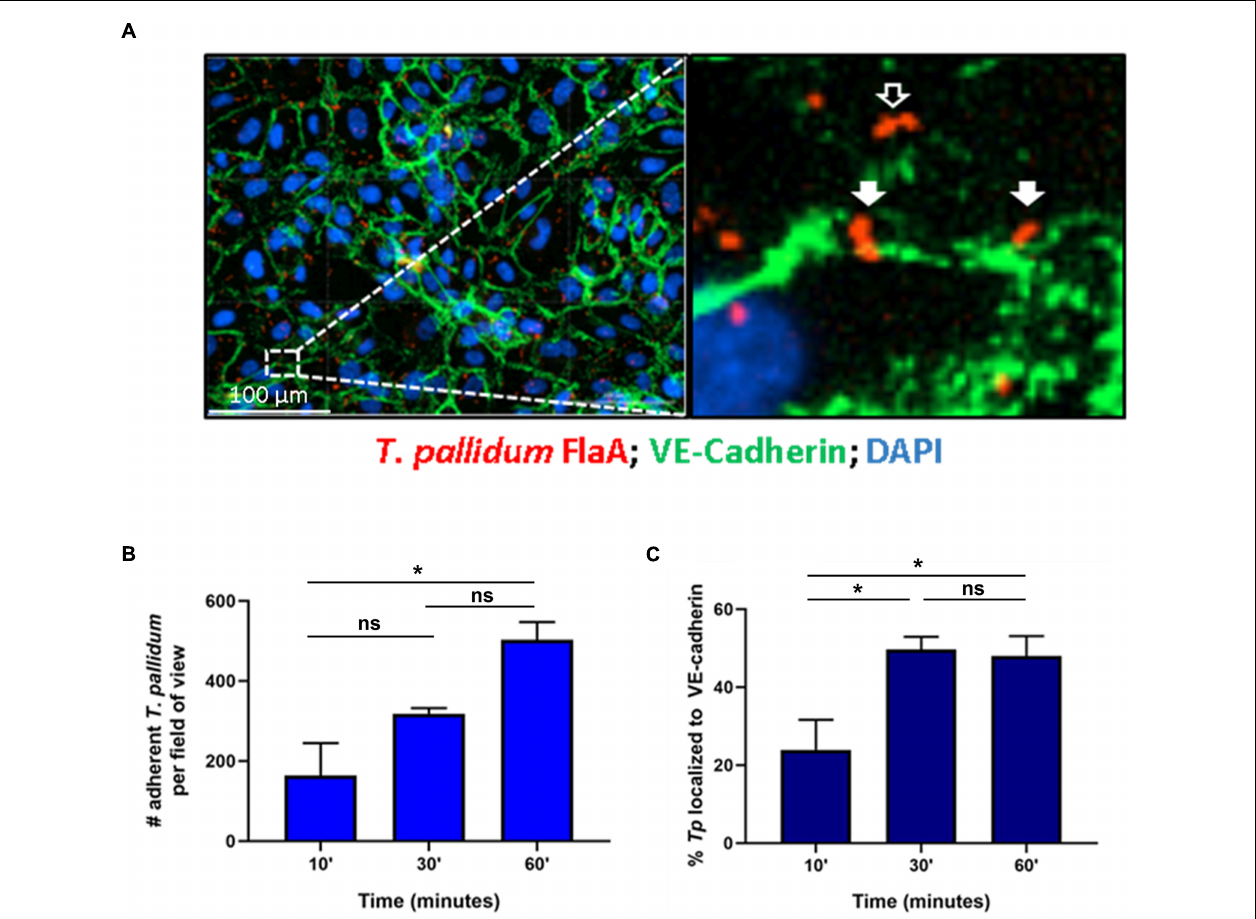
FIGURE 1 | Treponema pallidum localizes to endothelial intercellular junctions. (A) Representative immunofluorescence image of T. pallidum attached to endothelial cells. Inset reveals T. pallidum attached to endothelial cells in non-junctional regions (black arrow) and localized to VE-cadherin (white arrows). T. pallidum was co-incubated with confluent HUVEC monolayers for 10, 30, or 60 min. After washing to remove non-adherent treponemes, T. pallidum and HUVECs were fixed and permeabilized and T. pallidum attachment to endothelial monolayers was assessed via immunofluorescent staining of the T. pallidum periplasmic flagellar protein (FlaA, red) for treponemal quantification; HUVEC nuclei (DAPI, blue) and cellular margins (VE-cadherin, green) were stained to evaluate T. pallidum localization to cellular margins (green) or non-junctional areas. Colocalization with adherens junctions was evaluated by quantifying T. pallidum attached at sites with overlapping signal between FlaA (red; T. pallidum ) and intercellular junctions (green; VE-cadherin). (B) Time course of T. pallidum attachment to HUVECs after ( i ) 10-min ( ii ) 30-min, and ( iii ) 60-min co-incubations. Statistical significance was evaluated by one-way ANOVA comparing T. pallidum attachment over the time course ( p = 0.048) with Tukey’s post hoc comparison evaluating T. pallidum attachment between 10- and 30-min time points ( p = 0.25), 10- and 60-min time points (* p = 0.0427), and 30- and 60-min time points (ns; p = 0.1803). (C) Percent localization of T. pallidum to VE-cadherin intercellular junctions. Results are presented as mean ± SEM from three independent experiments. Statistical significance was evaluated by one-way ANOVA with Tukey’s post hoc comparison evaluating T. pallidum localization to junctions between 10- and 30-min time points (* p = 0.0401), 10- and 60-min time points (* p = 0.0482), and 30- and 60-min time points (ns; p = 0.9503). Images were acquired at × 200 magnification using a Cytation 5 Imaging Reader.